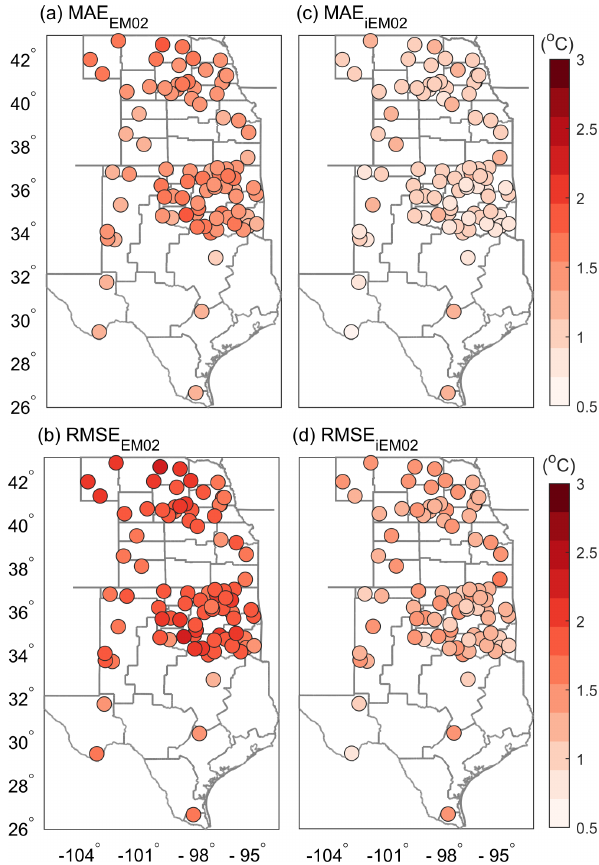
Figure 6. Spatial distribution of the mean absolute er- ror (MAE) (a, c) and RMSE (b, d) for an empirical model (EM02; a, b ) and improved modelEM02 (iEM02; c, d ). The color bar defines values of MAE (in degrees Celsius) and RMSE (in degrees Celsius).